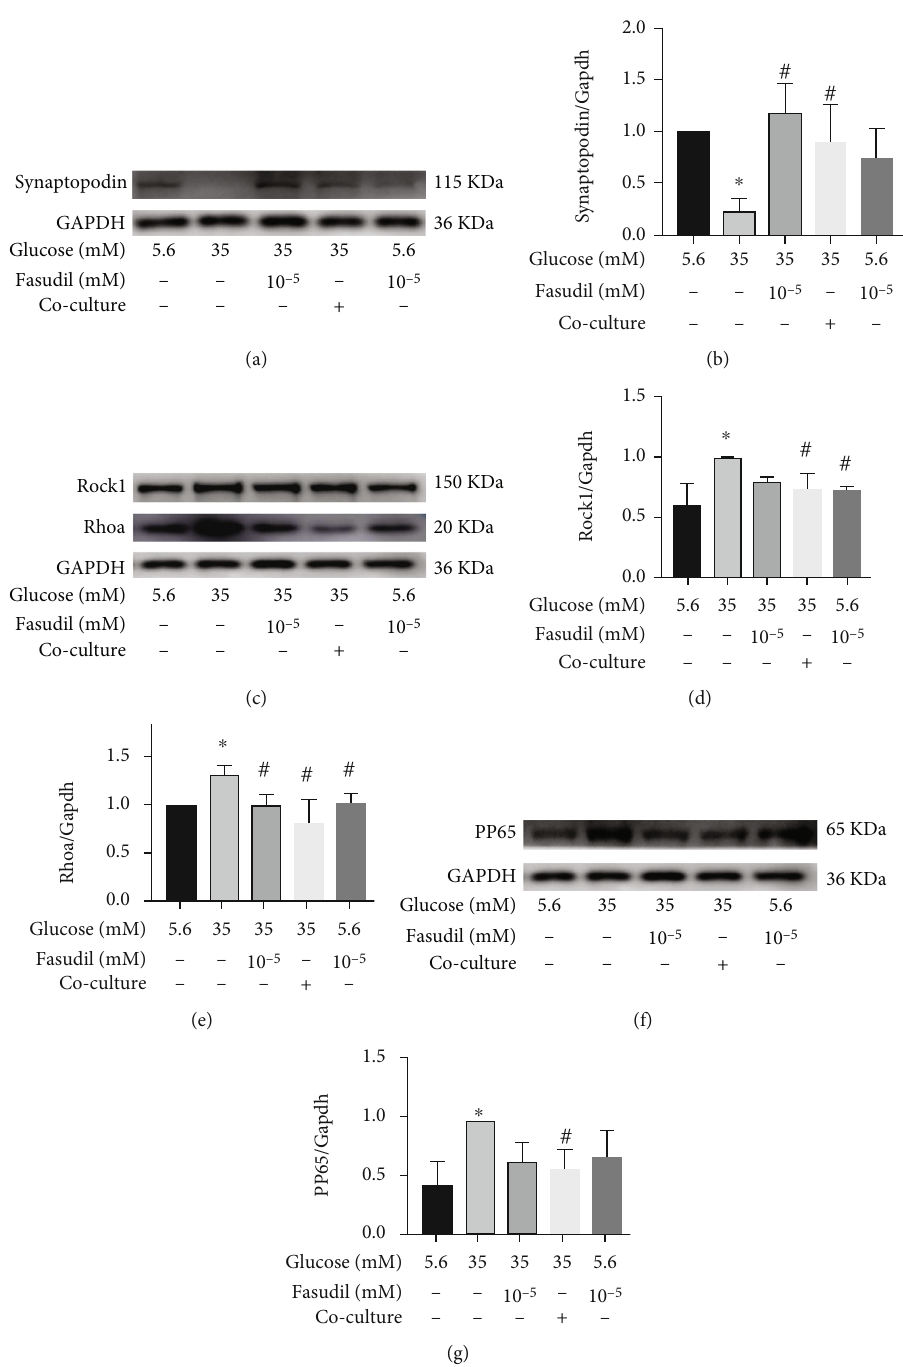
Figure 6: E ff ects of islet cells and fasudil on synaptopodin, RhoA/ROCK1and pp65 proteins of podocyte in high glucose (35.0 mmol/L glucose) environment. (a, b) The e ff ects of islet cells (islet cells were cocultured with podocytes) on synaptopodin protein and their semiquantitative analysis. (c – e) The e ff ects of islet cells on proteins of RhoA/ROCK1 signaling pathway and their semiquantitative analysis. (f, g) The e ff ects of islet cells and fasudil on pp65 protein and their semiquantitative analysis. ∗ P < 0 : 05 versus the control group (5.5 mM glucose), # P < 0 : 05 versus the HG (35 mM) alone. Coculture group: islet cells were cocultured with